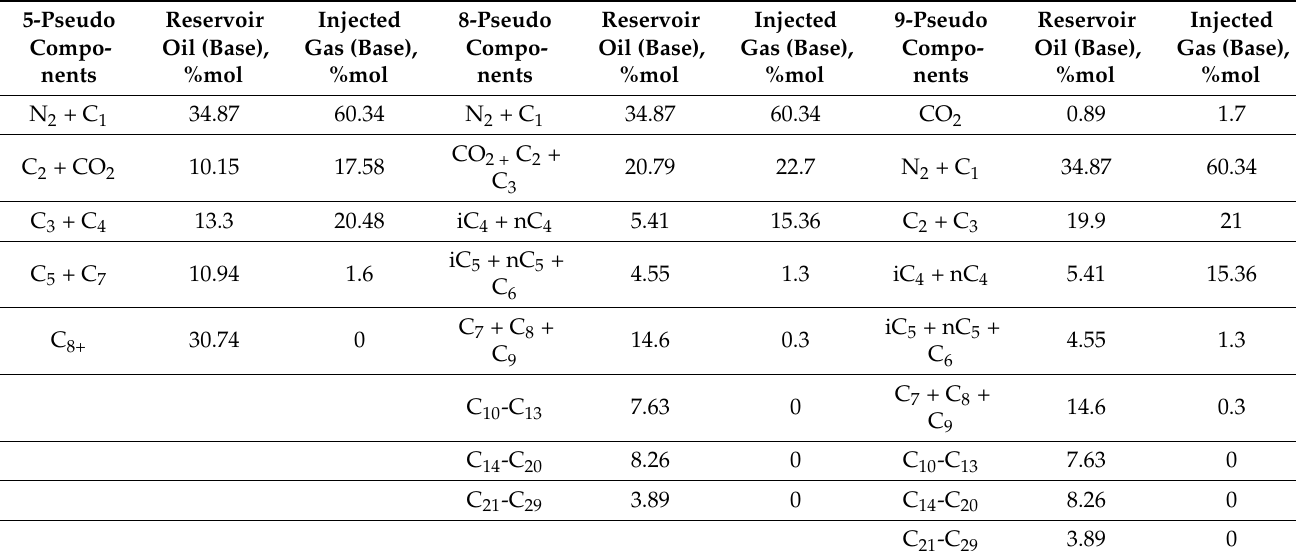
Table 6. Formation oil and injected gas compositions.